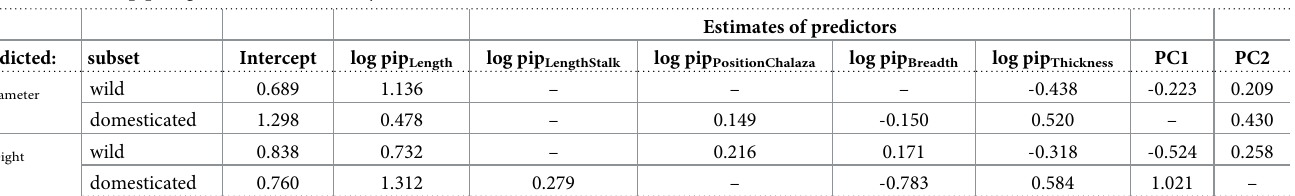
Table 1. Estimates for pip lengths used to infer berry dimensions.